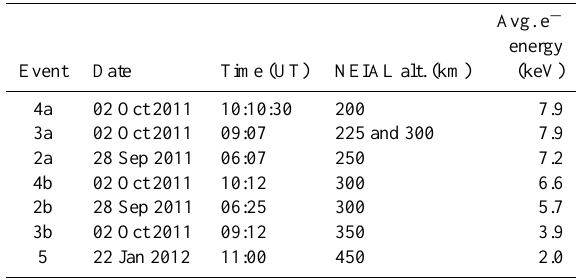
Table 4. Summary of the NEIAL altitudes and the corresponding average electron energy calculated from the auroral